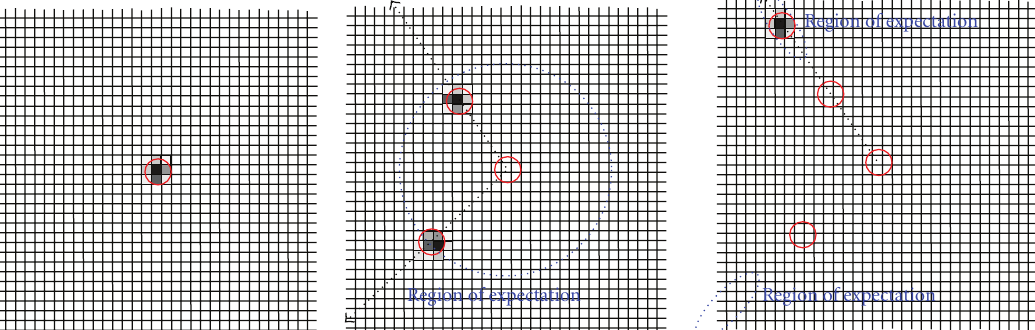
Figure 6: Motion hypotheses formulation. Three stages of a detection and classification of a transient. From left to right: the initial detection of the event on a first image, formation of a circular region of expectation based on assumption about some reasonable maximal speed of expectation; the formation of a set of hypotheses on object motion direction and speed based on an appearance of events inside this region on a second frame; the rejection of failed and acceptance of successful hypotheses based on events seen on a third frame. Objects not detected on a second frame are immediately rejected as a probably noise events; objects with determined motion parameters are tracked until their disappearance from field of view or fading out below the detection limit. For FAVOR and TORTORA systems with 0.13 s temporal resolution, this three-stage algorithm is completed in less than 0.4 seconds, resulting in nearly real-time detection and classification of